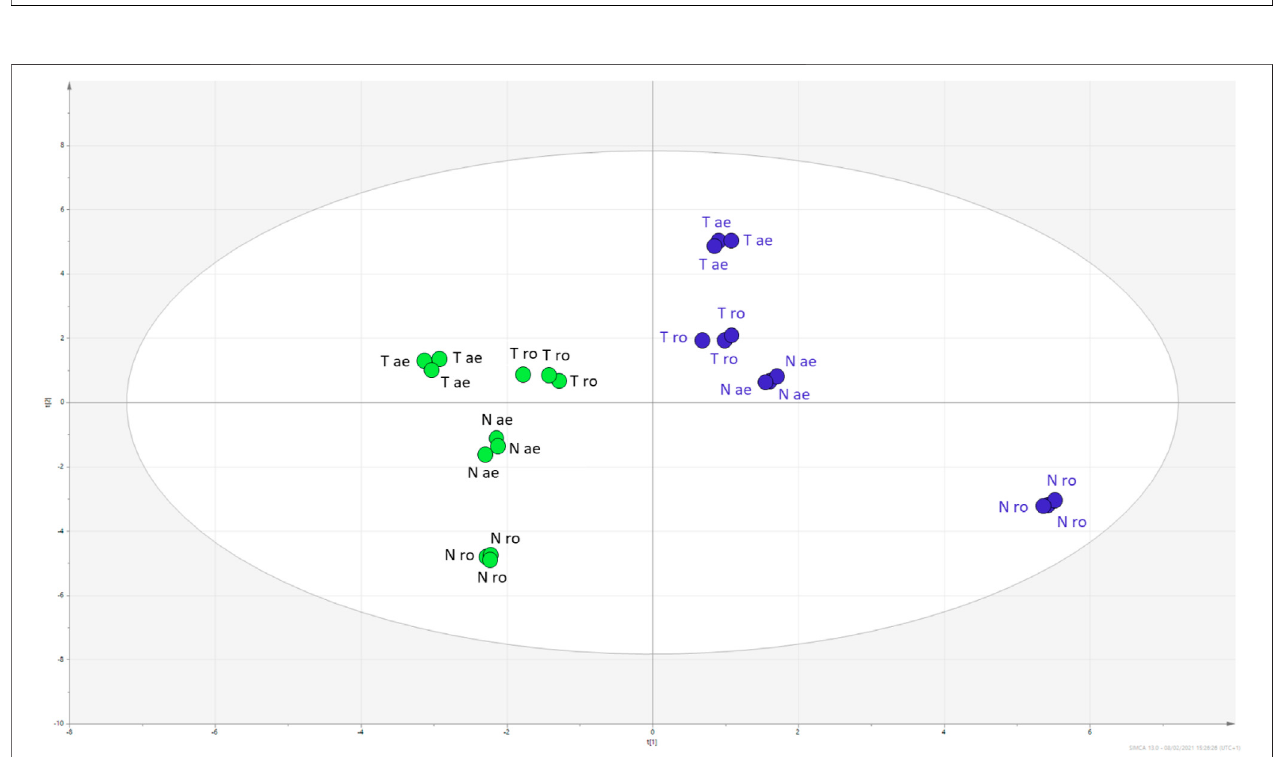
FIGURE 5 | PLS-DA scatter plot of H. triquetifolium (T) and H. neurocalicinum (N) aerial (ae) and roots (ro) extracts obtained with either methanol (green dots) or water (blue dots).